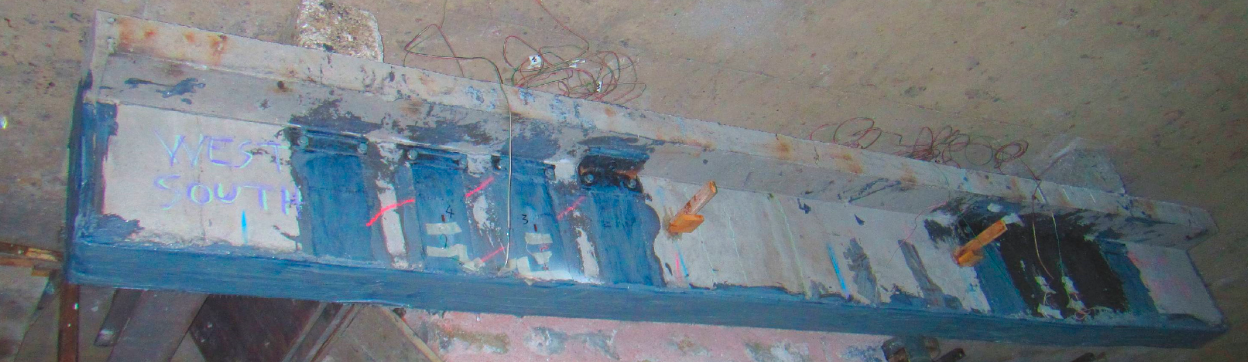
Figure 21. The 3rd st rengthening scheme . Open hoop CFRP strips with mechanical anchors at the West part and closed hoop anchor ropes at the East part (The same as in St rengthening scheme 2 ). The flexural upgrade of the 3rd strengthening scheme consisted of five (5) CFRP layers (each 0.131 mm thick and 120 mm wide) attached at the bottom side of the T-beam specimen.